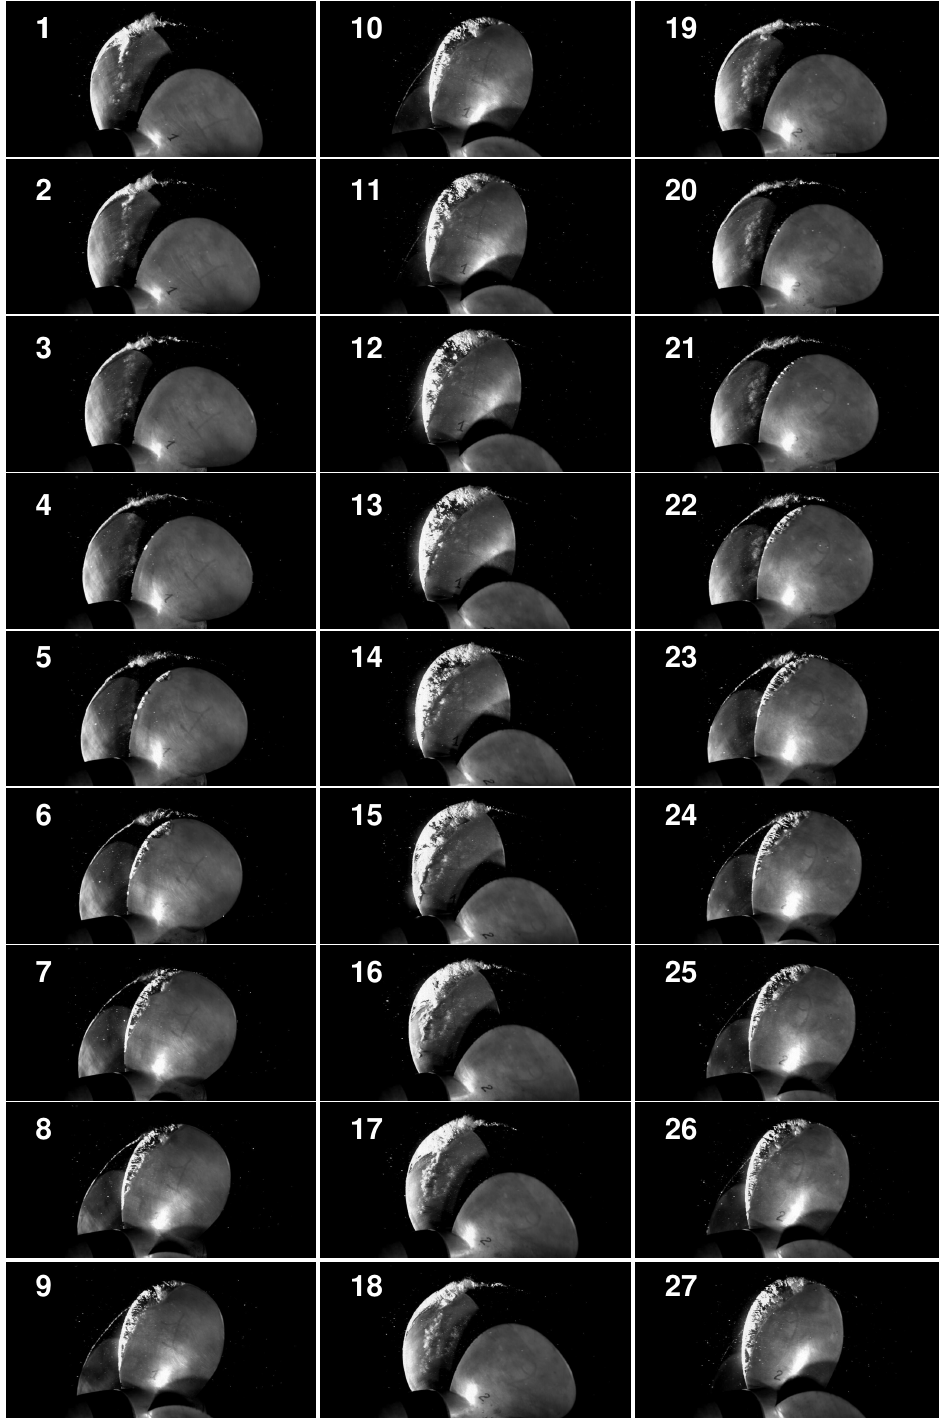
Figure 4. High-speed sequence of the cavitating propeller for σ 0 = 3.5. Inter-frame time = 500µs, angular step = 5.4 ◦ . Flow is from left to right, and the view is from the propeller back face, port side. The wake generator is on the